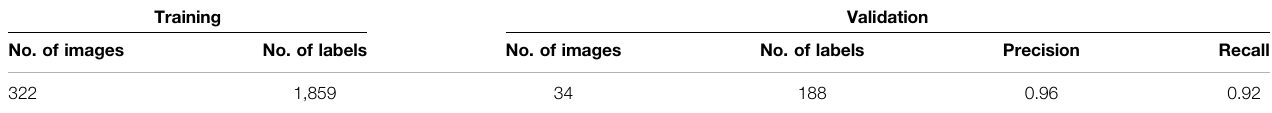
TABLE 3 | The number of images and labels, and detection quality for validation.